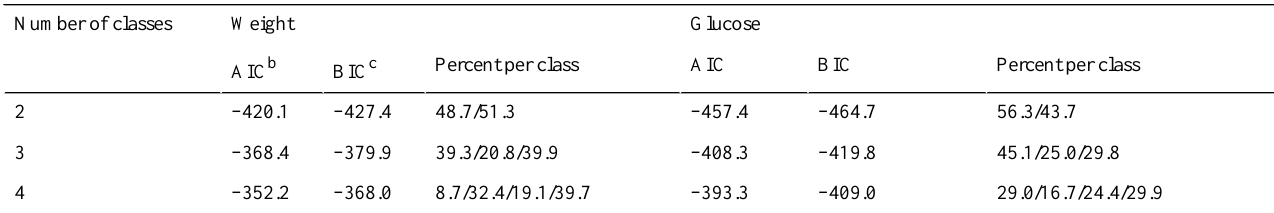
Table 4. Model fit by number of latent classes modeleda.